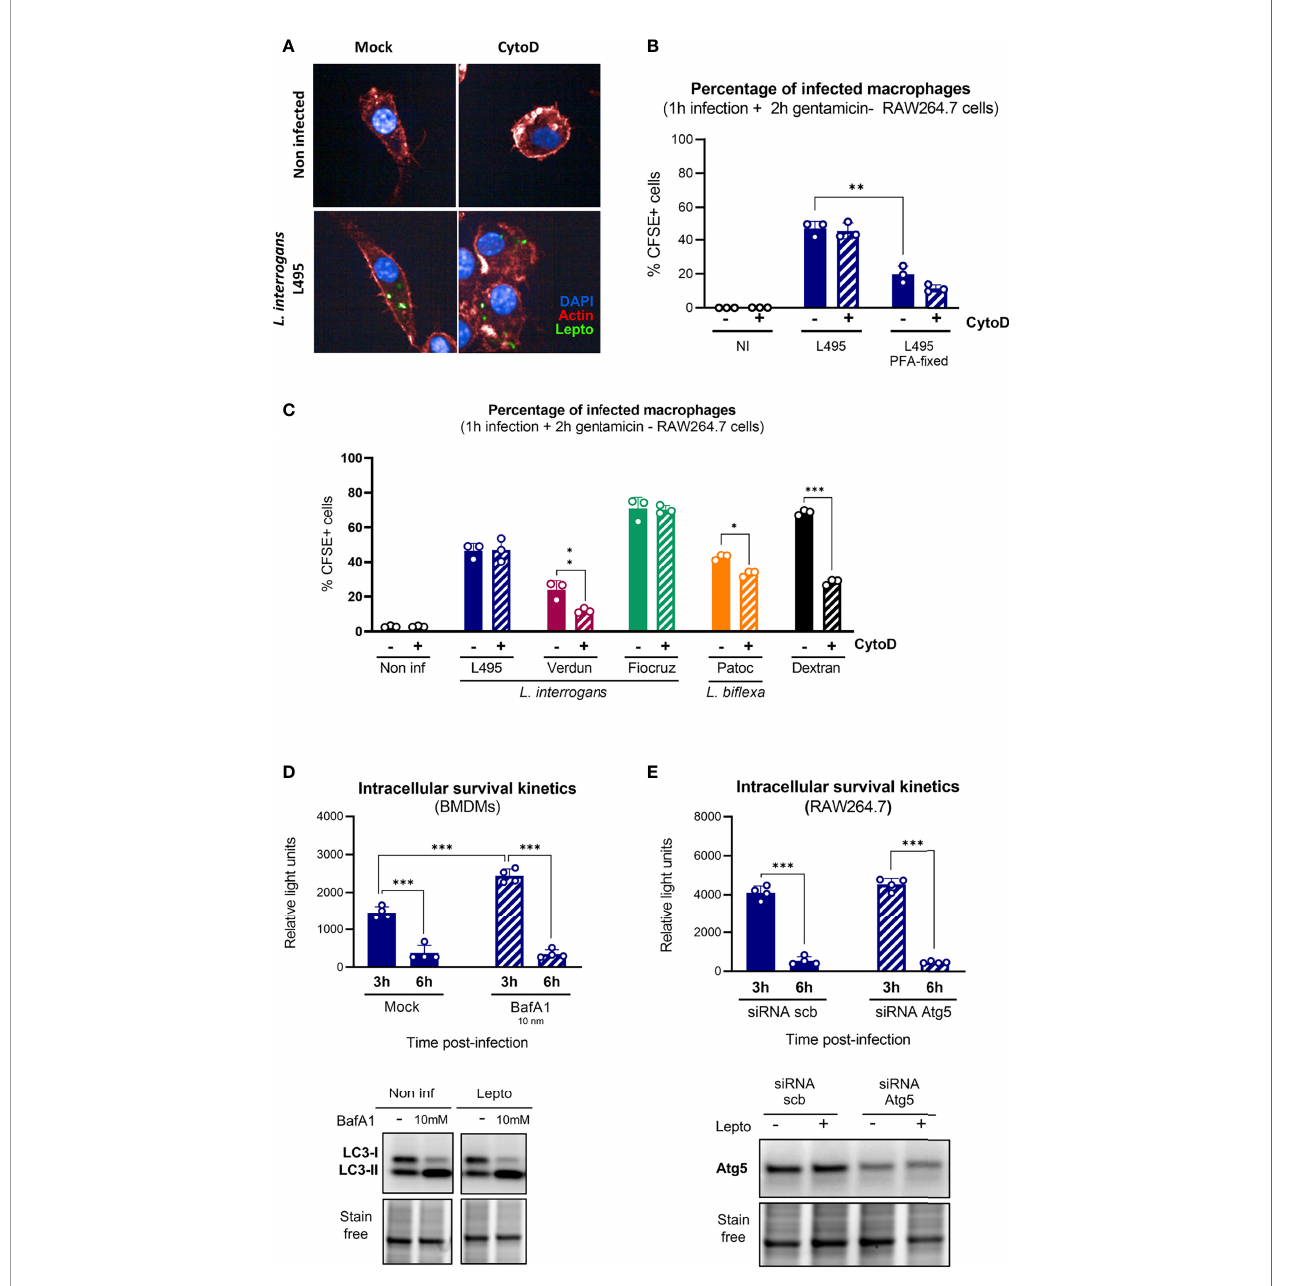
FIGURE 4 | Internalized leptospires are not degraded by lysosomal pathways. (A, B) High-content (HC) confocal microscopy (A) images and (B) analysis of RAW264.7 cells treated with Cyto D, infected for 1 h with MOI 100 of live or p FA – fi xed CFSE-labeled L. interrogans serovar Manilae strain L495 and after gentamicin protection assay. (C) HC confocal microscopy analysis of RAW264.7 cells treated with Cyto D, infected for 1 h with MOI 100 of CFSE-labeled L. interrogans serovar Manilae strain L495, serovar Copenhageni strain Fiocruz L1 – 130, serovar Icterohaemorrhagiae strain Verdun, or L. bi fl exa serovar Patoc strain Patoc I and after gentamicin protection assay. (D) Intracellular survival 3 and 6 h post-infection of L. interrogans serovar Manilae strain MFLum1 in BMDMs pretreated with 10 mM BafA1 and infected during 1 h with subsequent gentamicin protection assay. Intracellular survival was directly assessed by luminescence measurement on cell lysates diluted in EMJH. WB analysis of LC3 in BMDMs cells 3 h post-infection in the same conditions. (E) Intracellular survival 3 and 6 h post-infection of L. interrogans serovar Manilae strain MFLum1 in RAW264.7 transfected with scramble or Atg5 siRNA and infected during 1 h with subsequent gentamicin protection assay. Intracellular survival was directly assessed by luminescence measurement on cell lysates diluted in EMJH. WB analysis of Atg5 in RAW264.7 cells 3 h post- infection in the same conditions. (A – E) Bars correspond to mean +/- SD of technical replicates ( n > 3). Data presented are representative of at least two independent